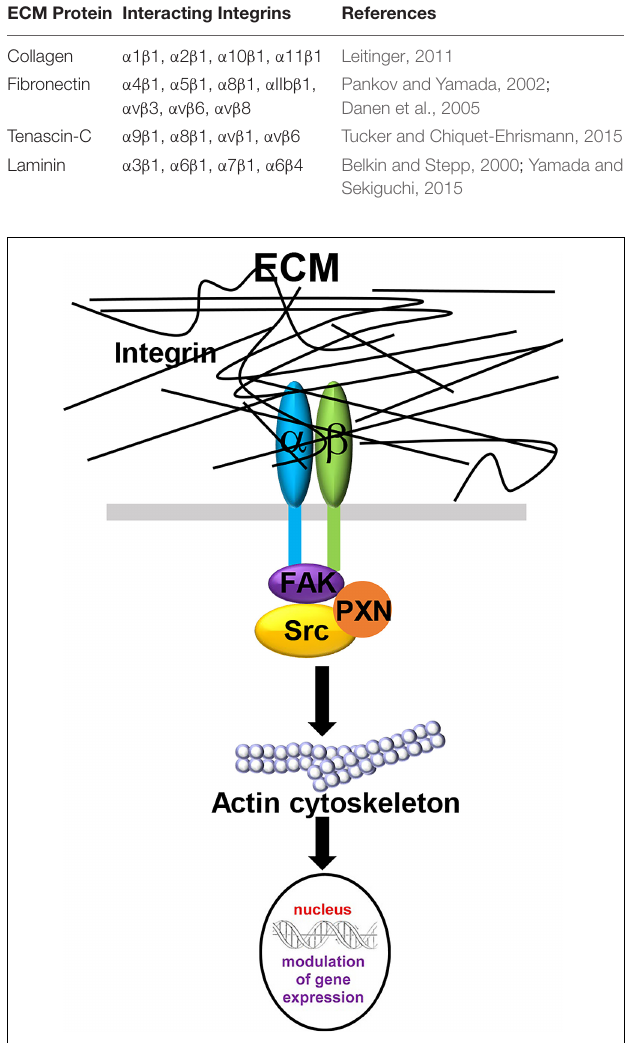
FIGURE 2 | The “outside-in” signaling mode in CAF-ECM interactions. When the membrane-bound integrin receptors interact with ECM proteins, integrin α - and β - subunits dimerize to activate downstream FAK1 and Src signaling and induce cytoskeleton remodeling, thereby converting external mechanical signals into cellular and biochemical signals inside the cells.